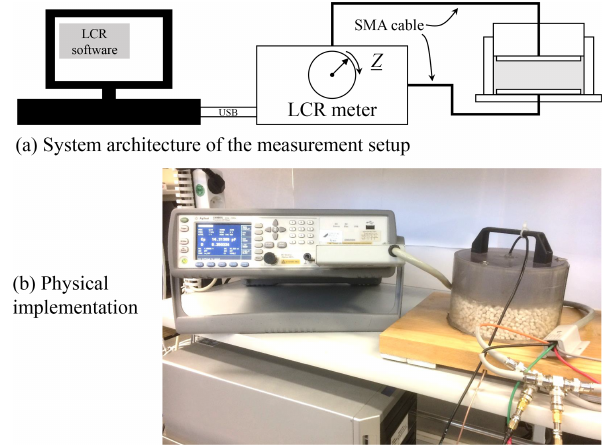
Figure 4. Measurement setup consisting of a PC, the LCR meter, and the measuring cell: (a) system architecture and (b) physical im- plementation (Bifano et al., 2021).